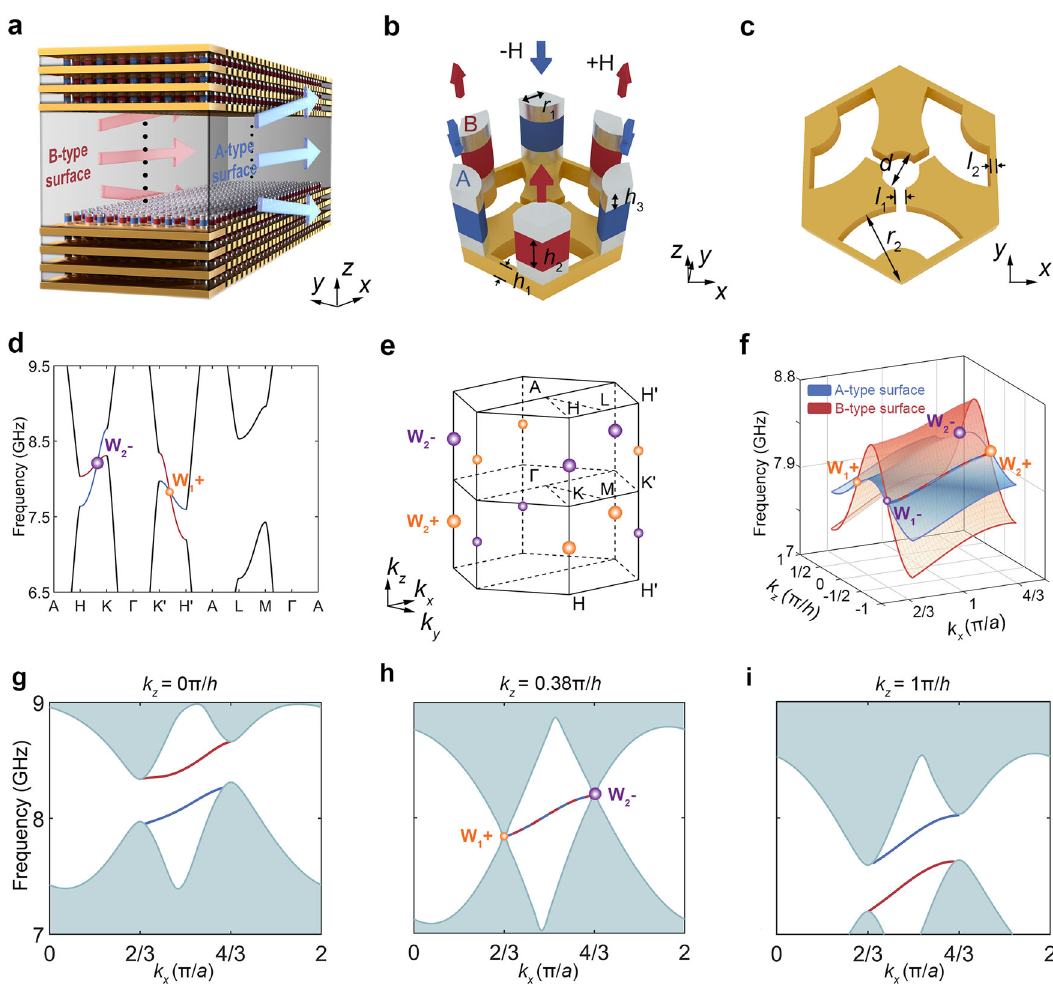
Fig. 1 | Design ofa 3D magnetic Weyl photonic crystal. a Conceptualillustration cell of perforated metallic plates with geometrical parameters r 2 =2.9mm, l d =1.5mm, l of antichiral surface states (red and blue arrows) that propagate in the same 1 =0.4mm, 2 =0.25mm. d Calculated bulk band structure of the magnetic Weyl photonic crystals along high-symmetry lines. Orange and purple direction on opposite surfaces of a 3D gyromagnetic Weyl photonic crystal. b The spheres represent two pairs of frequency-shifted WPs carrying opposite topologi- unit cell of 3D gyromagnetic photonic crystal consisting of two sandwiched gyro- calchargesof+1and − 1. e 3DbulkBrillouinzonewithidealtype-IIWPs. f Simulated magnetic rods (red and blue fan-shaped rods) sitting on the perforated metallic 2Dsurface dispersions ofA-type(blue curvedsheet)and B-type(red curved sheet) plate. The gyromagneticrods atdifferent sublatticesites ofthe honeycomb lattice surfaces. g – i Simulated surface dispersions for fi xed values of g k z =0 π / h , areoppositelymagnetized by pairsof permanentmagnets (silver fan-shaped rods) h k z =0.38 π / h and i k z =1 π / h , respectively. The blue (red) lines indicate the A-type withreversedbiasingdirection.Thered(blue)arrowsindicatethebiasedmagnetic fl uxesalong + z ( − z )directions. The latticeconstants in the xy -plane and z -direction (B-type) surface state dispersion, respectively, and cyan regions represent the projected bulk are a =7.5mm and h =6.5mm, and the other geometrical parameters are h h h r 1 =1.3mm, 1 =2.5mm, 2 =2mmand 3 =1mm, respectively. c Top view of aunit